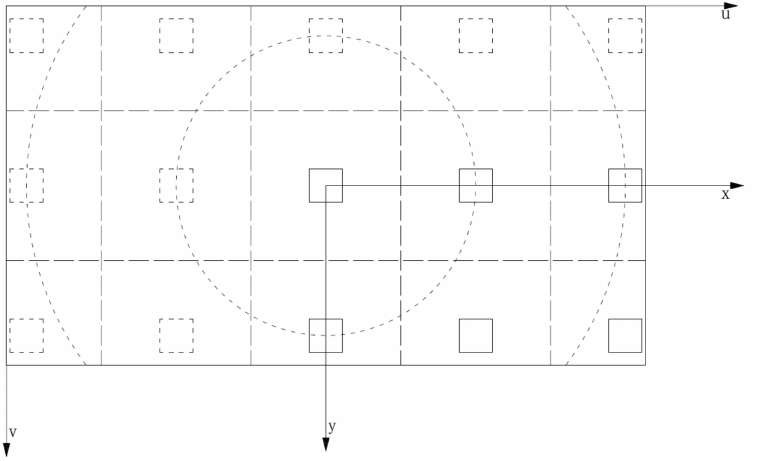
Figure 6. The projection of the sampling area in the pixel frame and image frame. The x -axis, y -axis constitute the image frame, and the u-axis and v-axis constitute the pixel